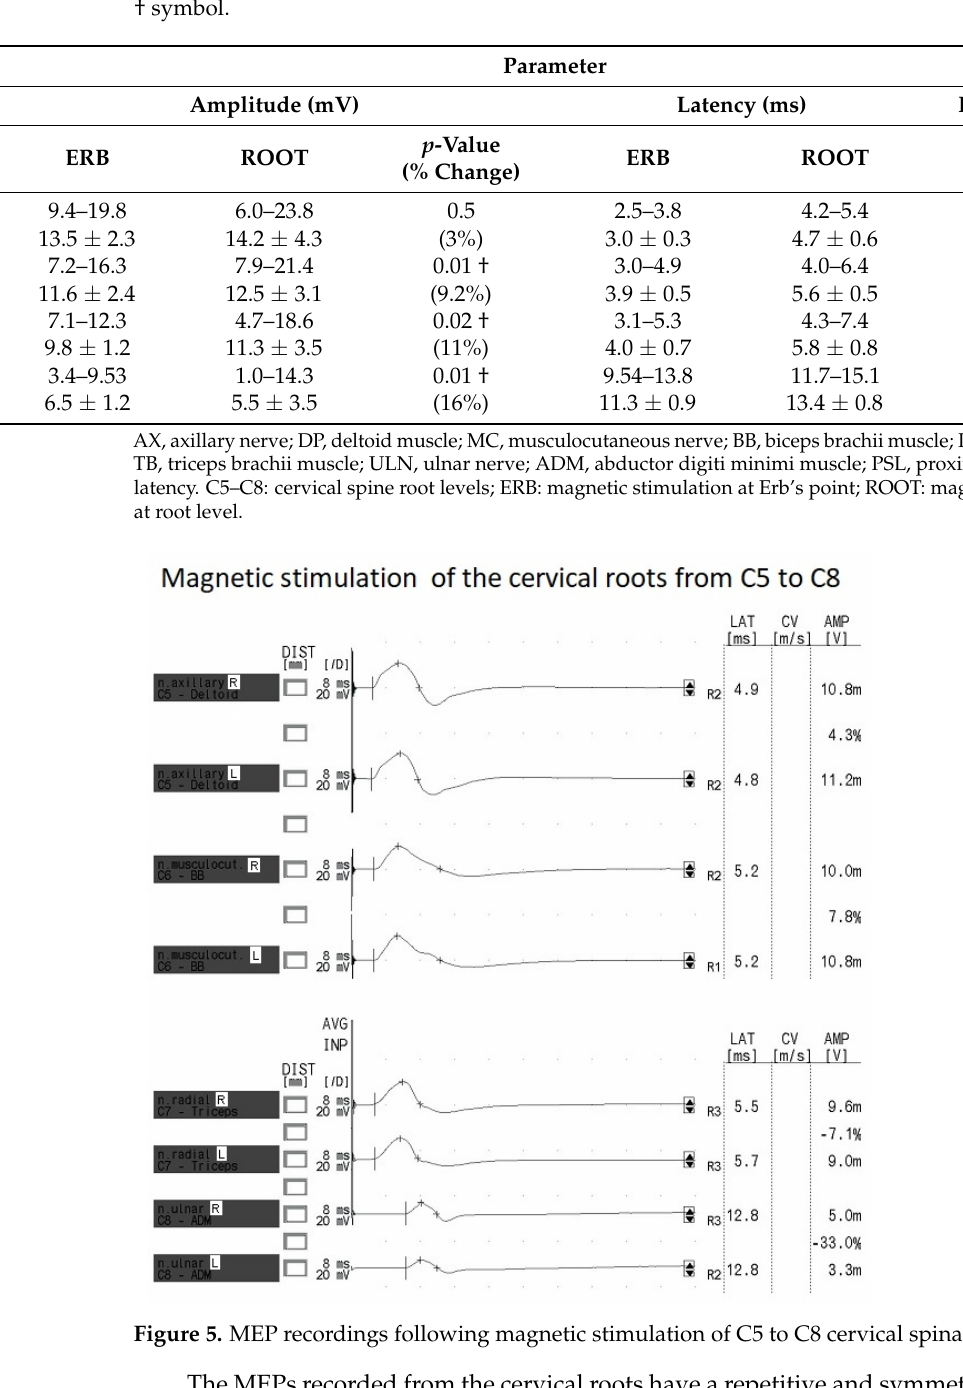
Table 6. Results of mean values for 10-point visual analog pain scale (VAS) reported by women and men.